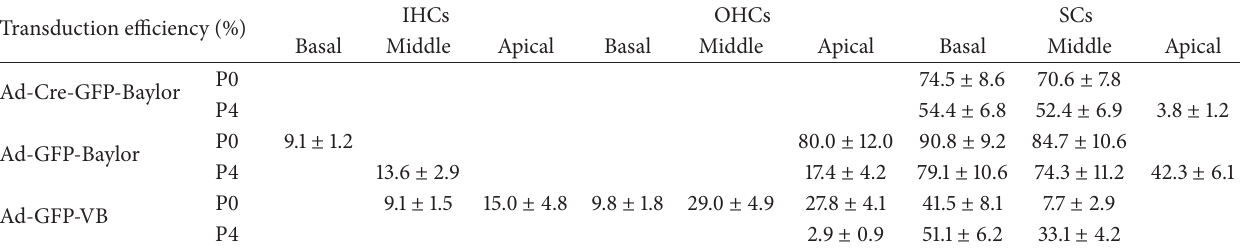
Figure 1: Ad-Cre-GFP-Baylor transduces supporting cells when injected into mouse cochlear at P0. Representative confocal images of whole- mount fluorescent immunolabeling of cochlea injected at P0 to illustrate the basal (a), middle (b), and apical turns (c), as compared to the contralateral uninjected middle turn of cochlea (d). Myo7a labels hair cells, and Sox2 labels supporting cells. Ad-Cre-GFP-Baylor mainly transduces supporting cells in basal and middle turns. Scale bars: 10 𝜇 m. Table 1: Comparison of in vivo transduction efficiency in different cell types and cochlear regions four days after injection of three adenoviral vectors into P0 or P4 mouse cochleae. 𝑁 = 4 per condition. Apical: apical turn of the cochlea, basal: basal turn of the cochlea, IHCs: inner hair cells, middle: middle turn of the cochlea, OHCs: outer hair cells, P0: injected at postnatal day 0, P4: injected at postnatal day 4, and SCs: supporting